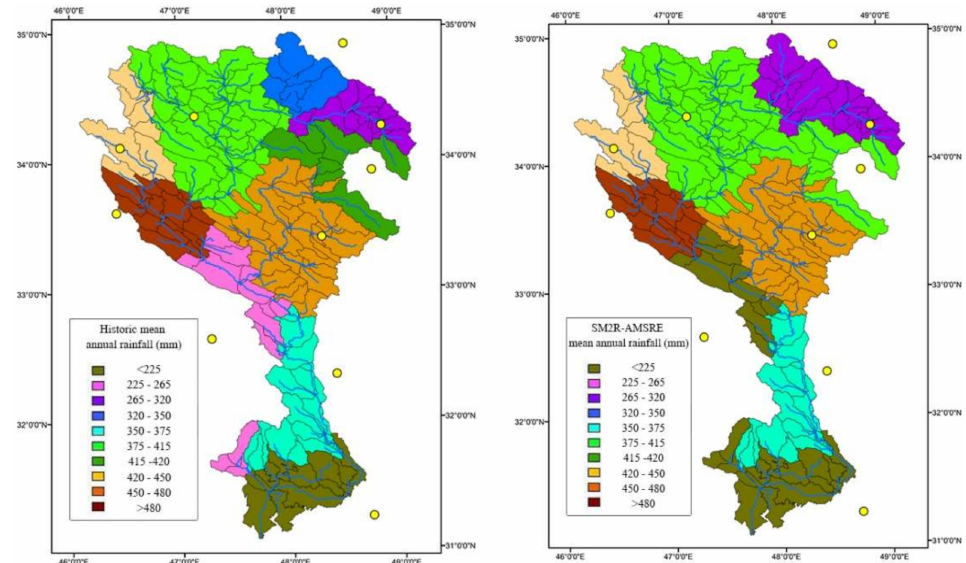
Figure 5. Spatial distributions of rain-gauge-measured (left panel) and SM2R-AMSRE- estimated mean annual rainfall (right panel) over the KRB for January 2003 to September 2006.